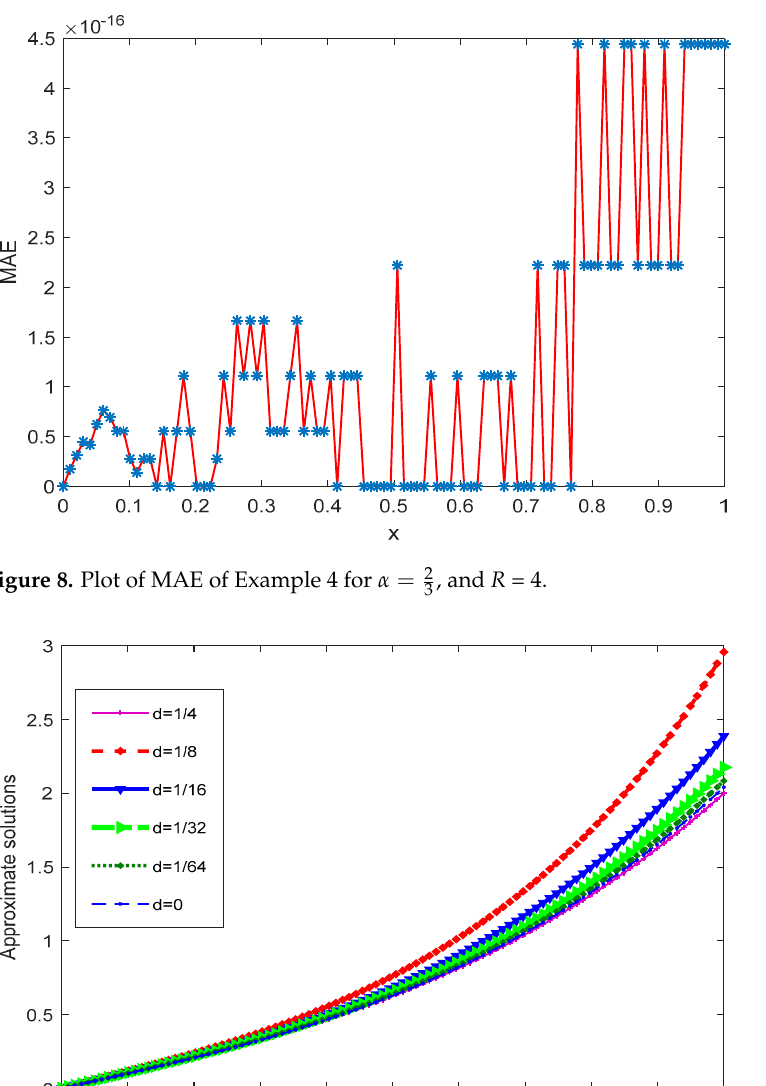
Figure 9. The numerical solutions of Example 4 for different values of 𝑑 .